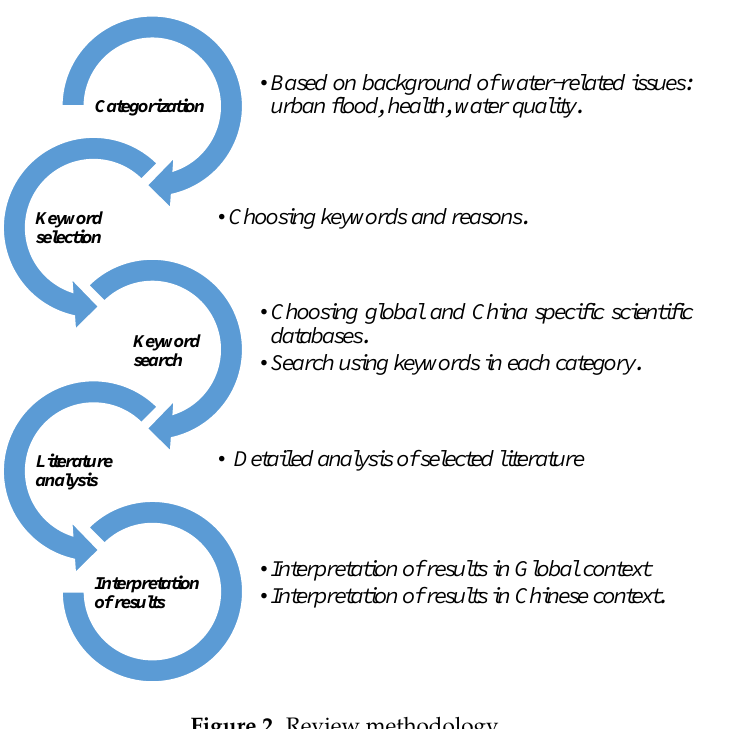
Figure 2. Review methodology. Figure 2. Review